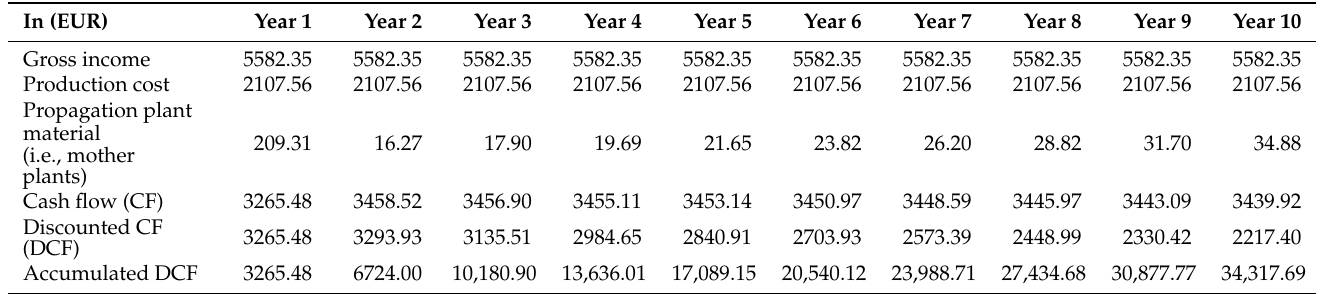
Table 15. Economic analysis (in EUR) associated with the novel and sustainable production model (NSM) for Abelia grandiflora